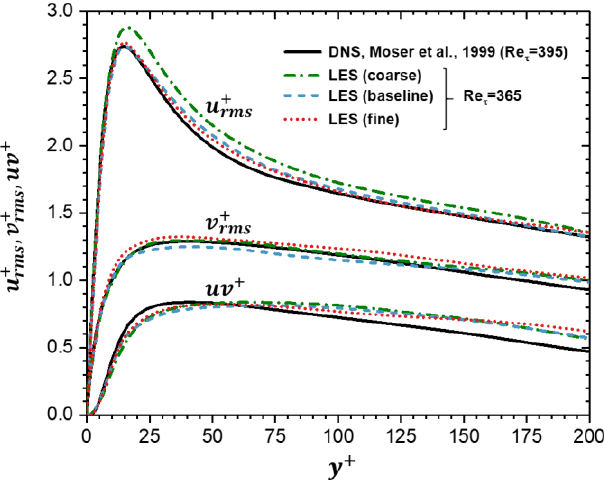
Figure 4. Mean flow fluctuations normalized by friction velocity at Re τ = 365.